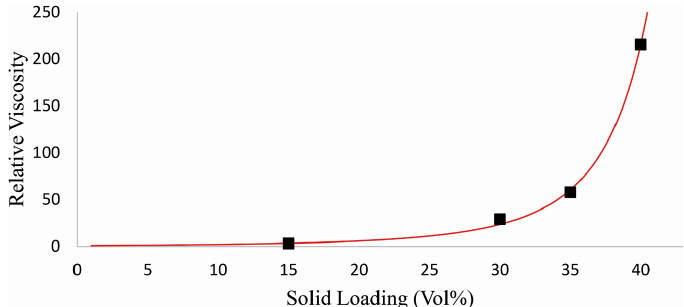
Figure 4. Influence of solid loading in 3Y-TZP ceramic slurries with 2wt% of Disperbyk-111 at a shear rate of 30 s